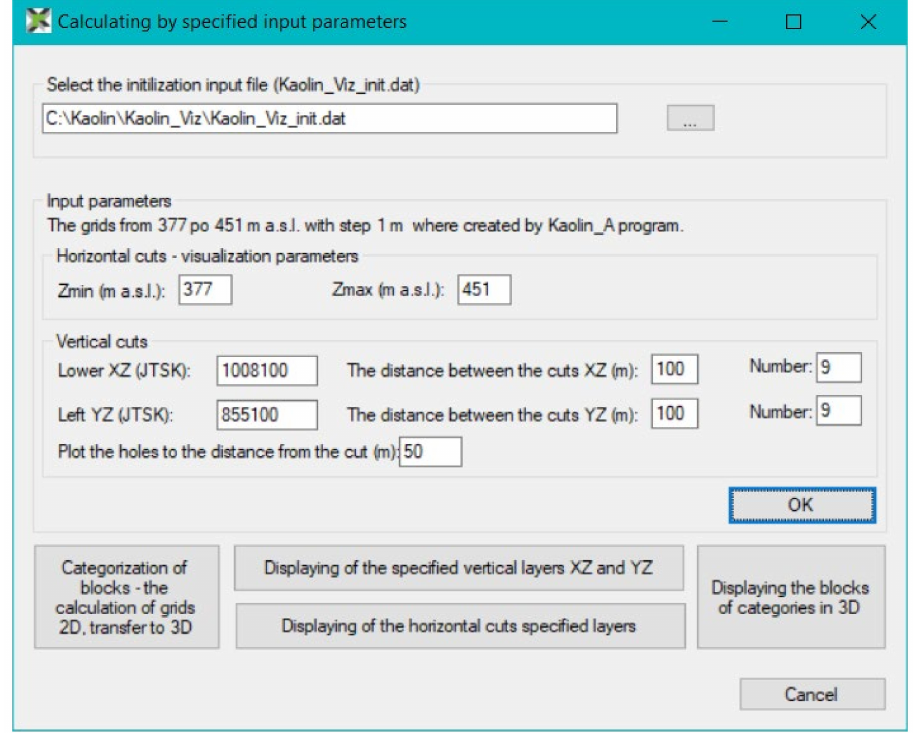
Figure 17. Window of the program Kaolin_Viz after the confirmation of input